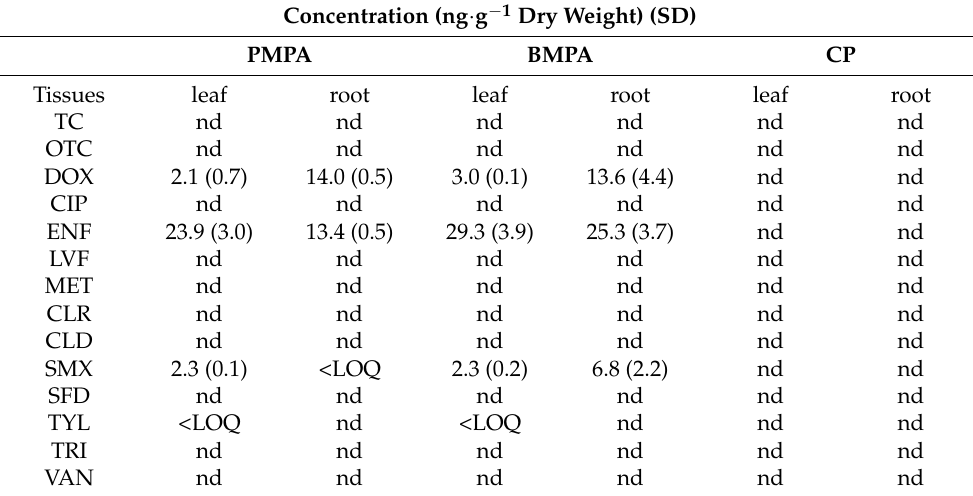
Table 1. Concentrations of selected pharmaceuticals in plant